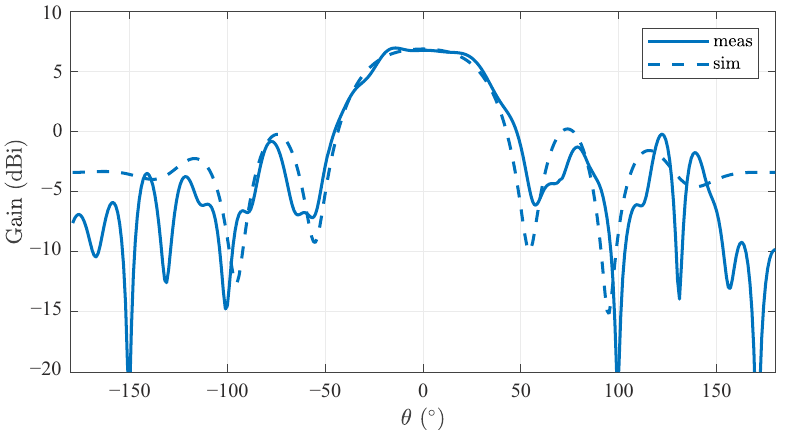
Figure 12. Simulated and measured antenna pattern at center frequency of 10GHz and Φ = 0.